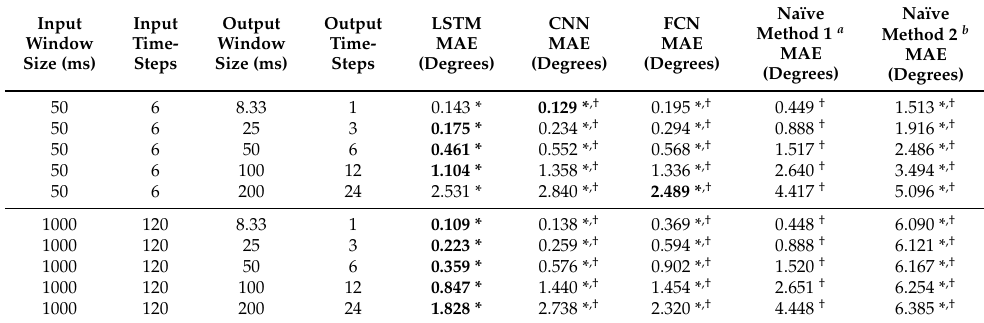
Table 4. Benchmarking performance of deep learning